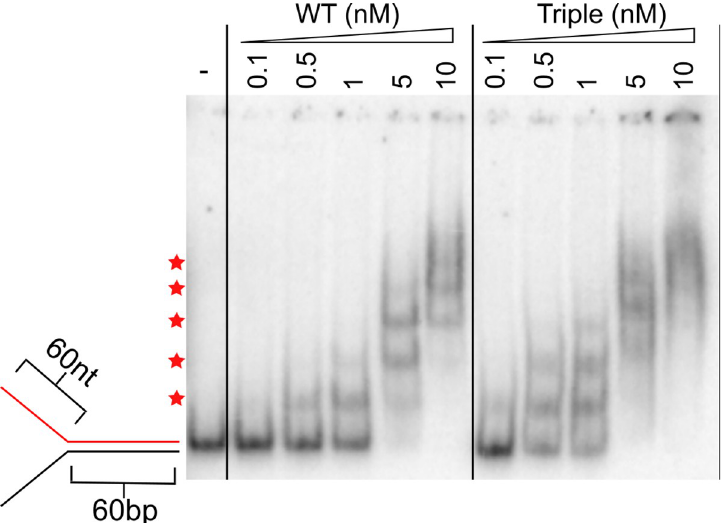
Fig 5. Extended fork substrates allow loading of additional PriA molecules. EMSA with PriA variants at indicated concentrations on extended two-stranded fork (1 nM, molecules). Substrate is depicted with radiolabeled strand shown in red. Red stars indicate locations of distinct, shifted bands. Gel is representative of at least three replicates.